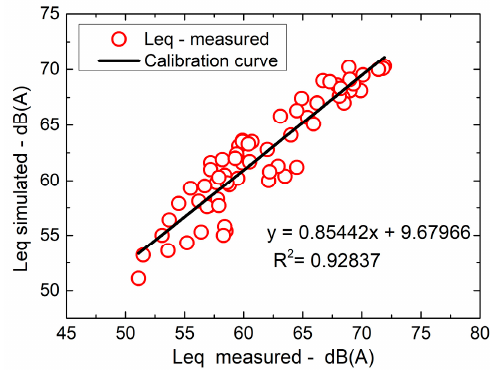
Figure 5. Calibration curve of the simulations.